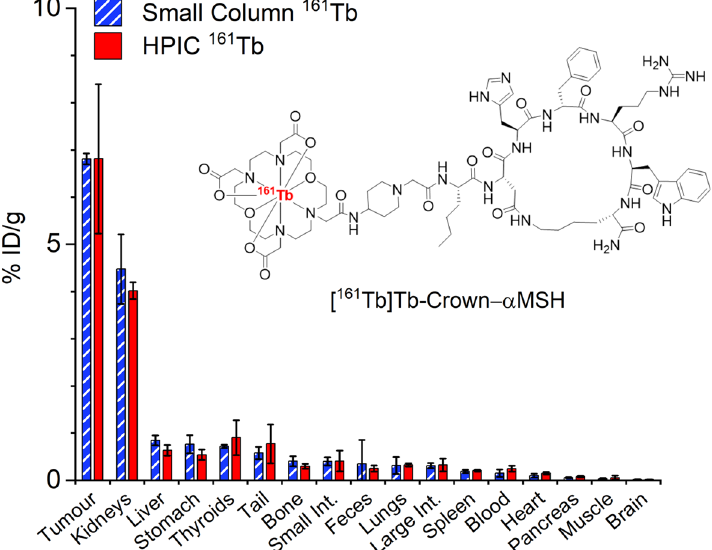
Fig. 7 Biodistribution of [ 161 Tb]Tb-crown-αMSH in male C57BL/6 J mice bearing B16-F10 tumour at 2 h post injection. Error bars reflect standard deviation (n =